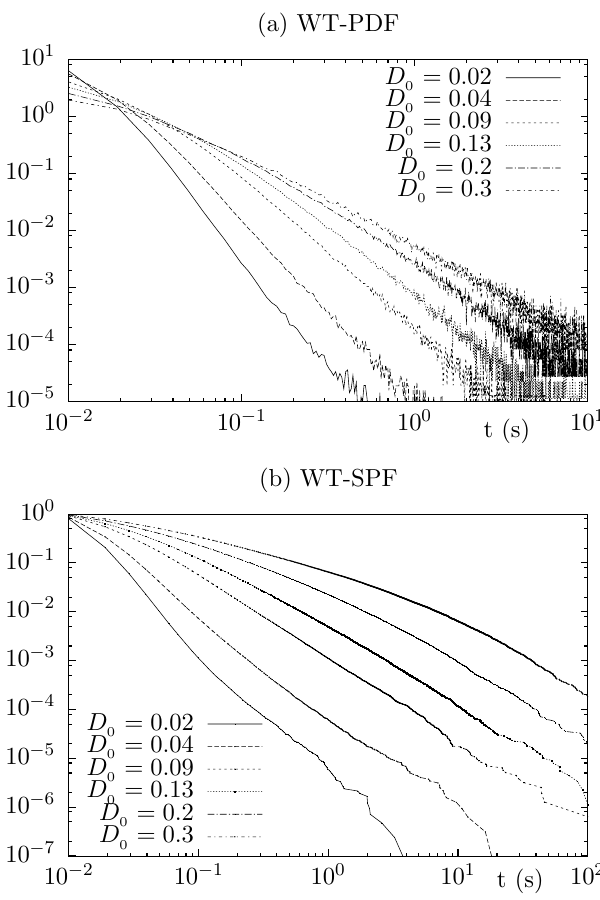
Fig. 3. Computation of the fractal dimension D counting method. (a) Renewal model given by Eqs. (11)–(12), T 1; (b) turbulence